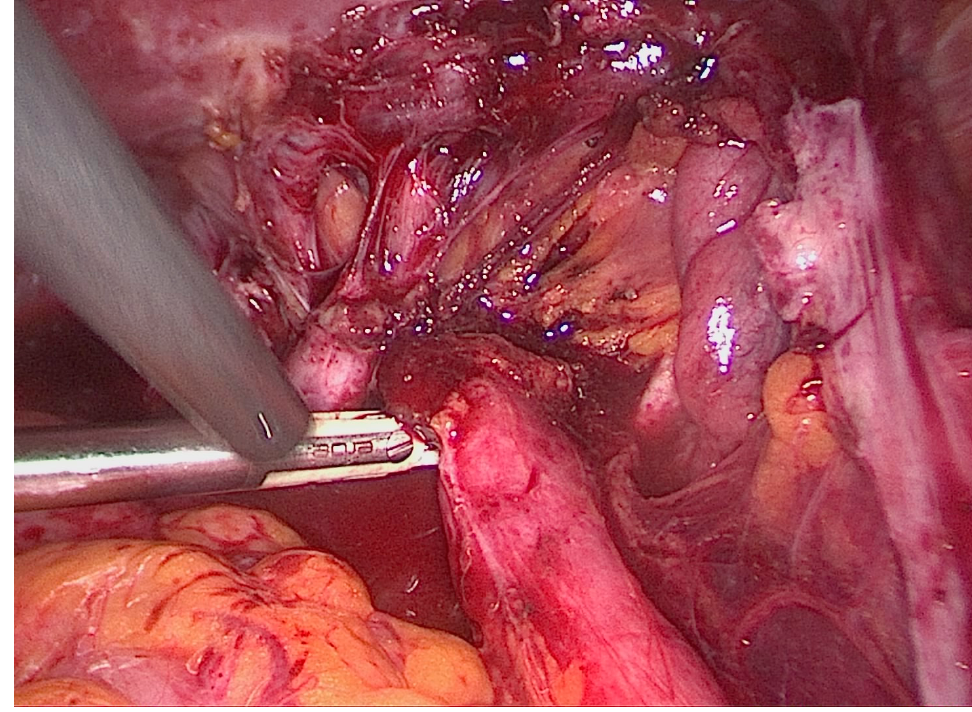
Figure 8. Laparoscopic depiction of right ureteral deep endometriosis leading to